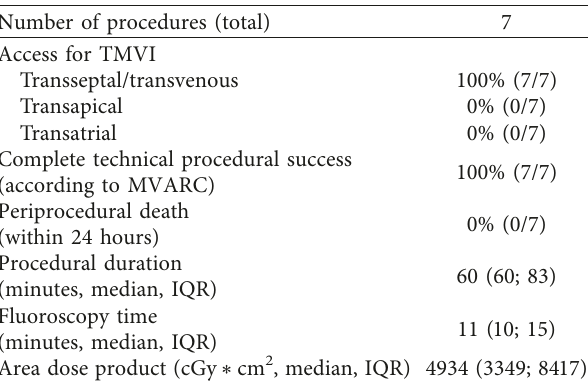
Figure 5: Detailed baseline and procedural characteristics of all patients treated by TMVI. Table 2: Procedural